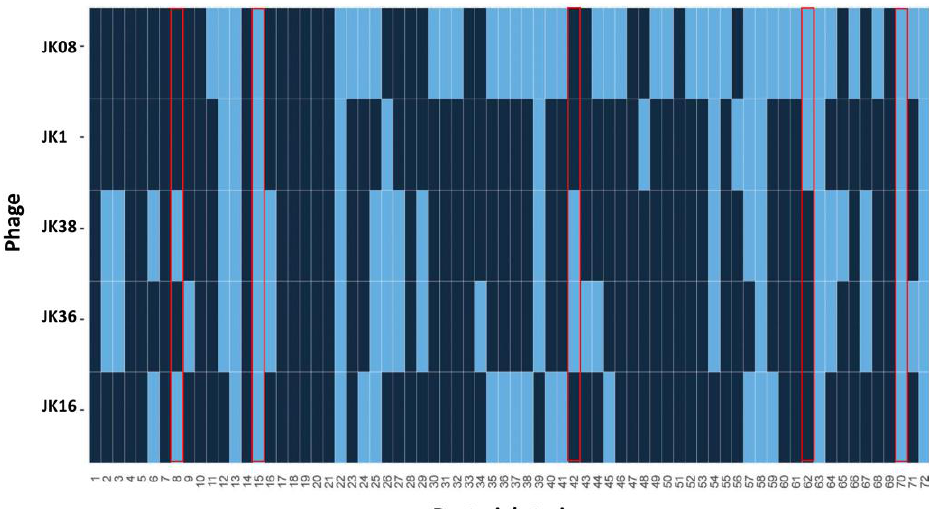
Figure 1. Heat map detailing the host range of phages JK1, JK08, JK16, JK36, and JK38 against the ECOR collection of 72 strains (numbered 1–72). Light blue indicates infection and dark blue indicates absence of infection. Host range data for JK16, JK36, and JK38 is adapted from [27]. Strains highlighted in a red box represent those selected for the infection model assays.